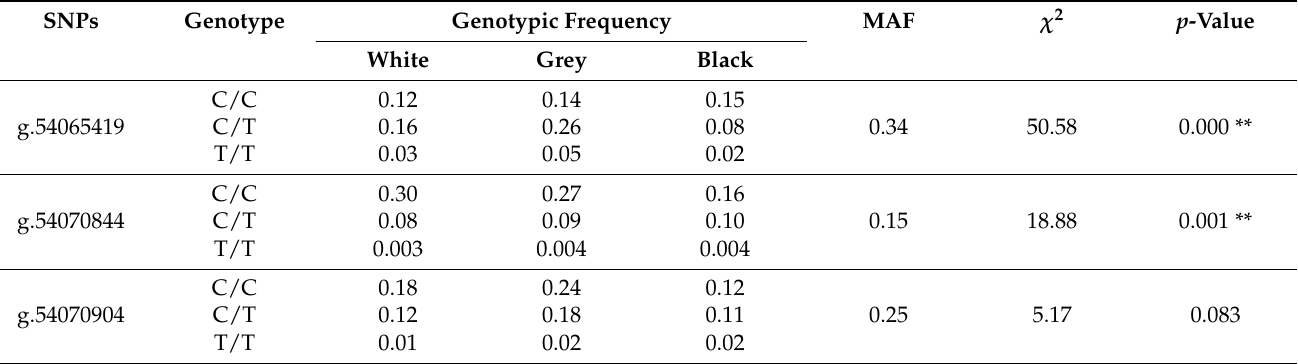
Table 4. Association between duck plumage color phenotypes and SOX10